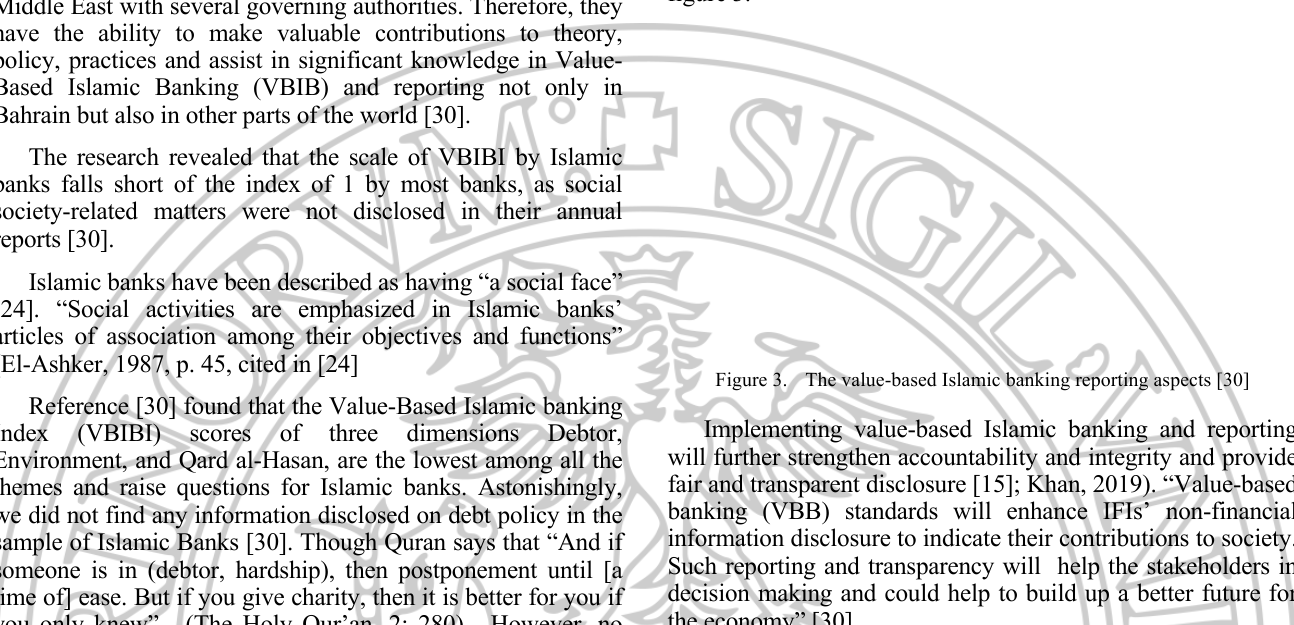
Figure 3. The value-based Islamic banking reporting aspects